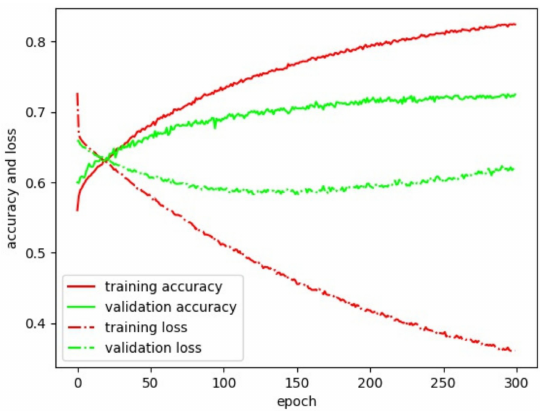
Figure 7. Accuracy and loss for our fine-tuned VGG19.